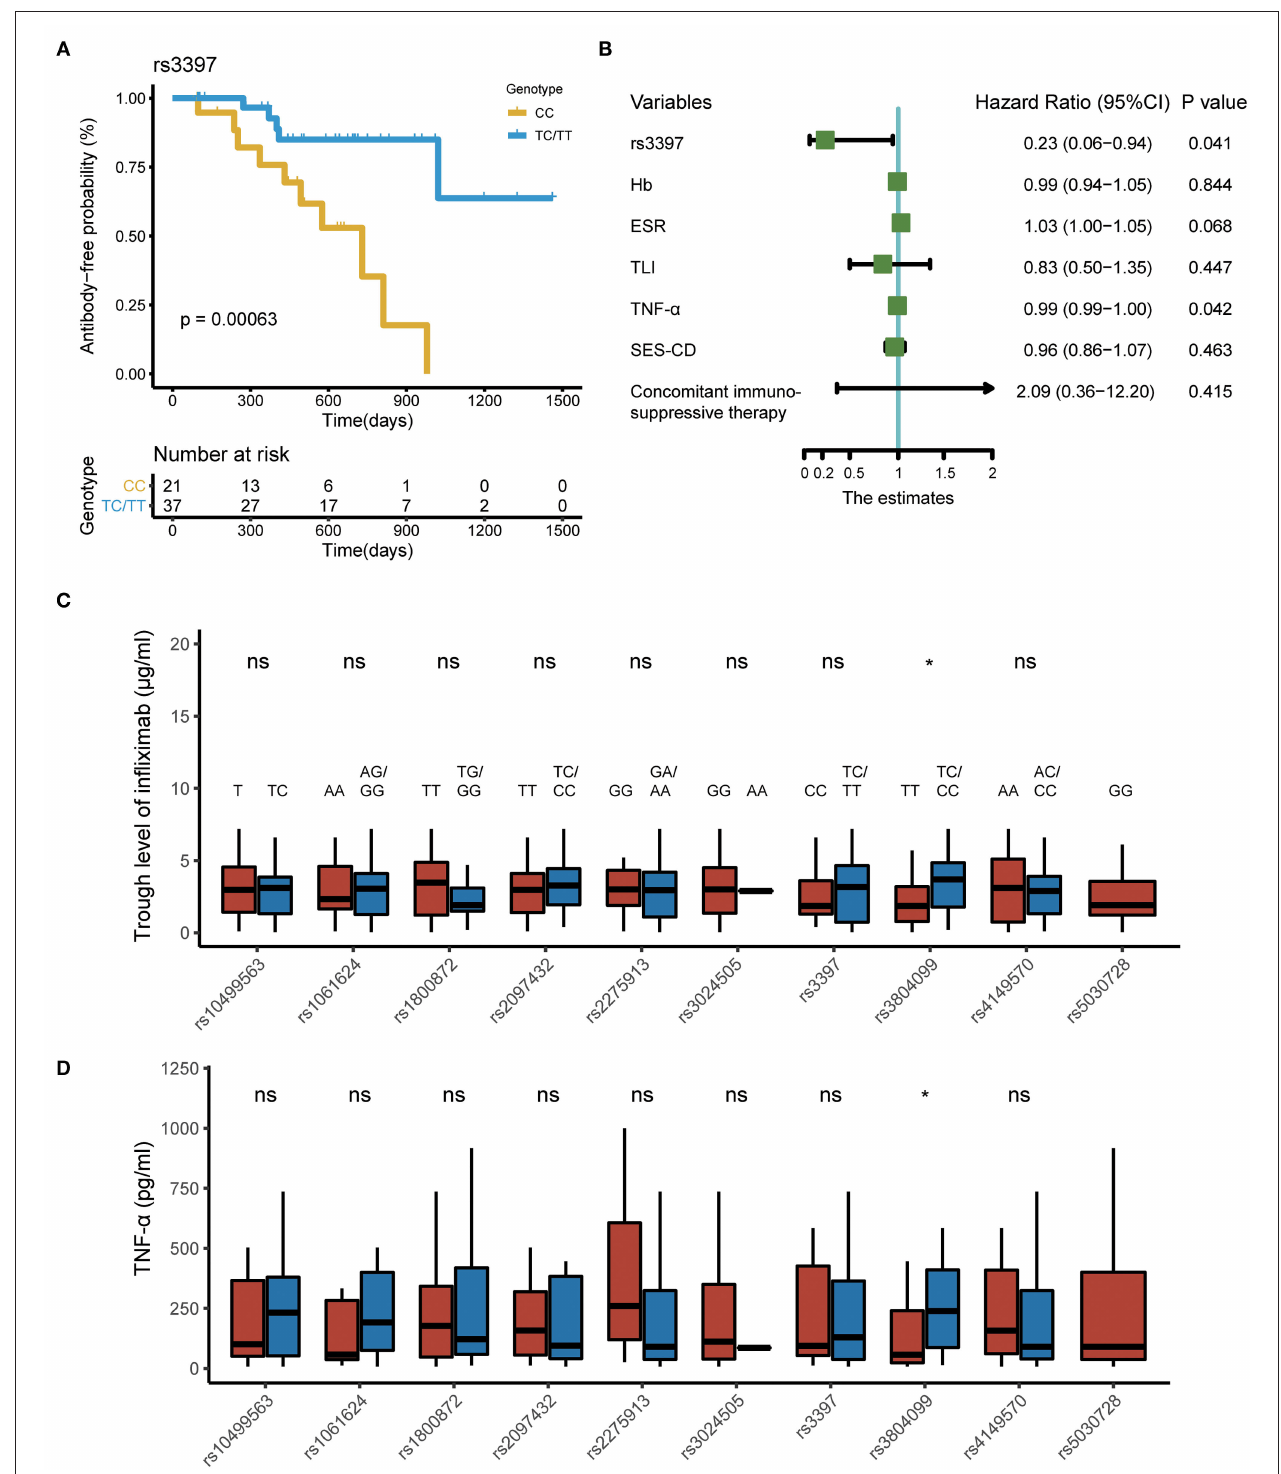
FIGURE 3 | SNPs associated with pharmacokinetics of IFX in CD. (A) Kaplan–Meier curve depicting the difference in antibody-free probability between patients with the CC genotype and those with the TC/TT genotype. (B) Forest plot showing the results of multivariate Cox regression model. (C) Polymorphisms associated with TLI at week 14. (D) Polymorphisms associated with serum TNF- α level at week 14. SNPs, single-nucleotide polymorphisms; IFX, infliximab; CD, Crohn’s disease; TNF- α , tumor necrosis factor alpha.